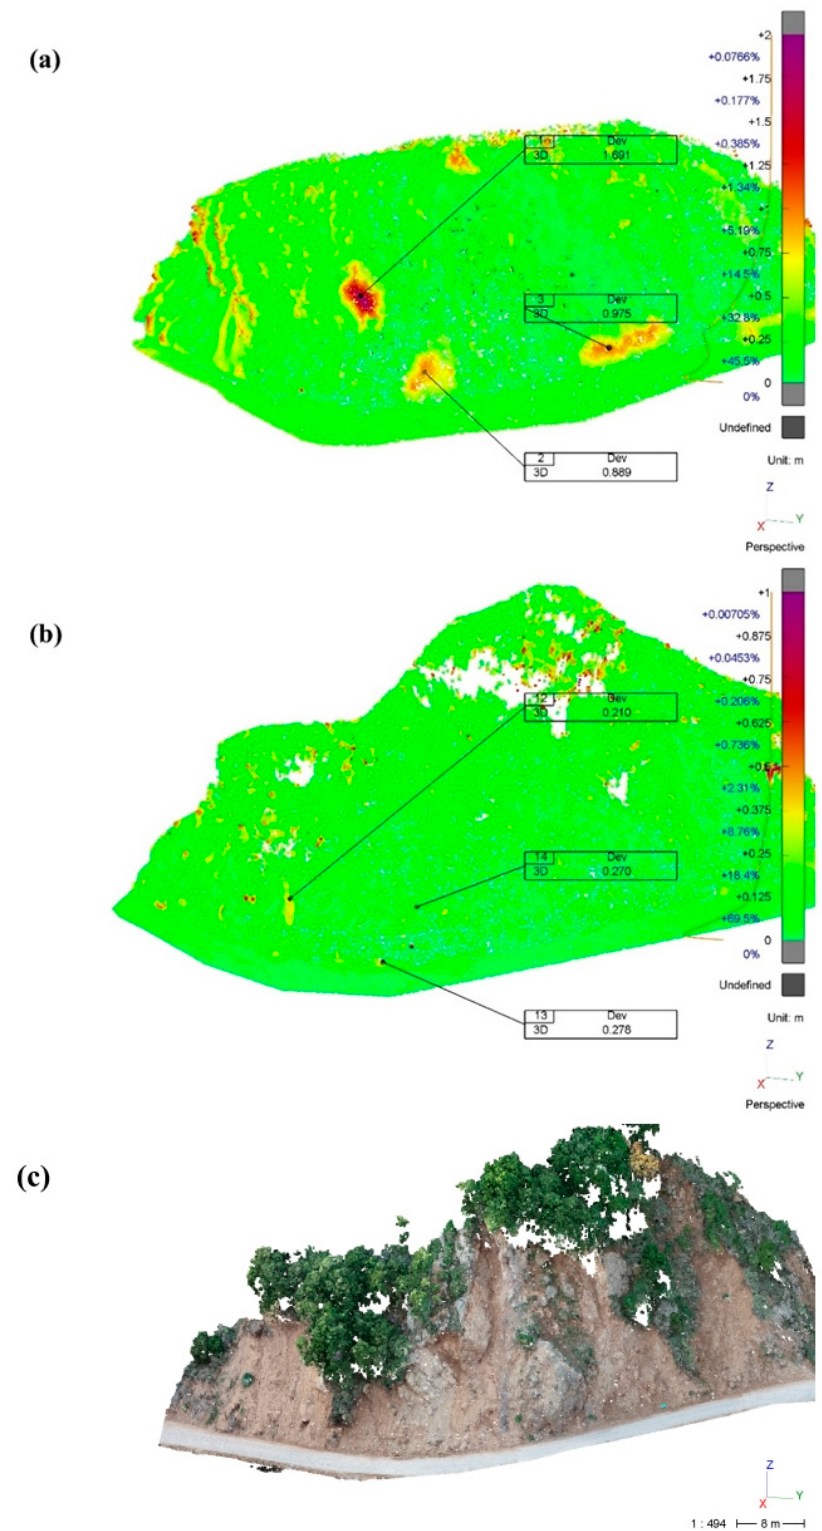
Figure 11. ( a ) Cloud-to-cloud comparison between the UAV point clouds, acquired on 10 June 2020 and 25 September 2020. ( b ) Cloud-to-cloud comparison between the UAV point clouds, acquired on 25 September 2020 and 7 November 2021. ( c ) UAV point cloud acquired on 25 September 2020 in RGB.